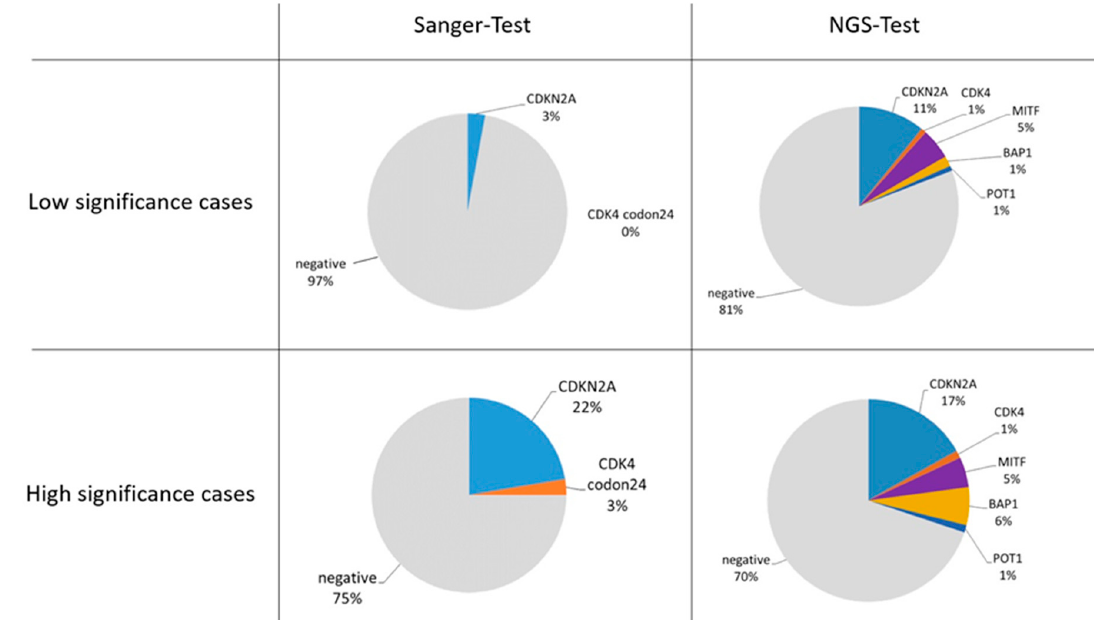
Figure 2. Spectrum of genetic alterations identified in “low significance” and “high significance” cutaneous melanoma patients by the use of both Sanger and NGS testing approach. The percentage of cases is given nearby each data series represented in the pie charts.